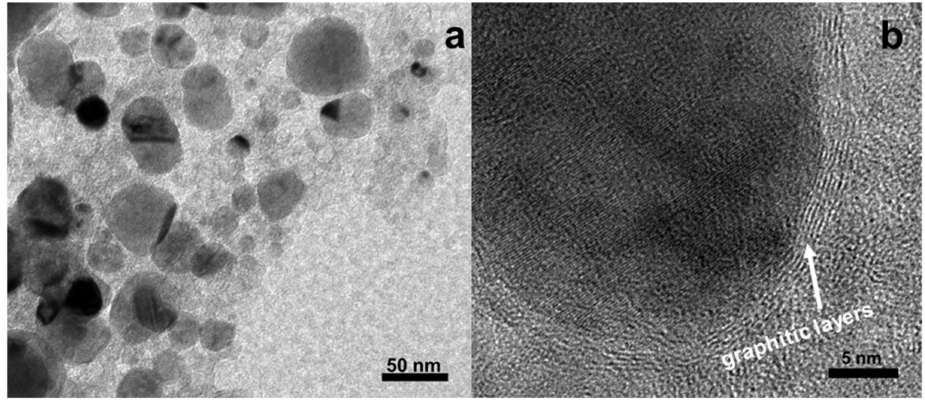
Figure 1. ( a )TEM and ( b ) HRTEM images of